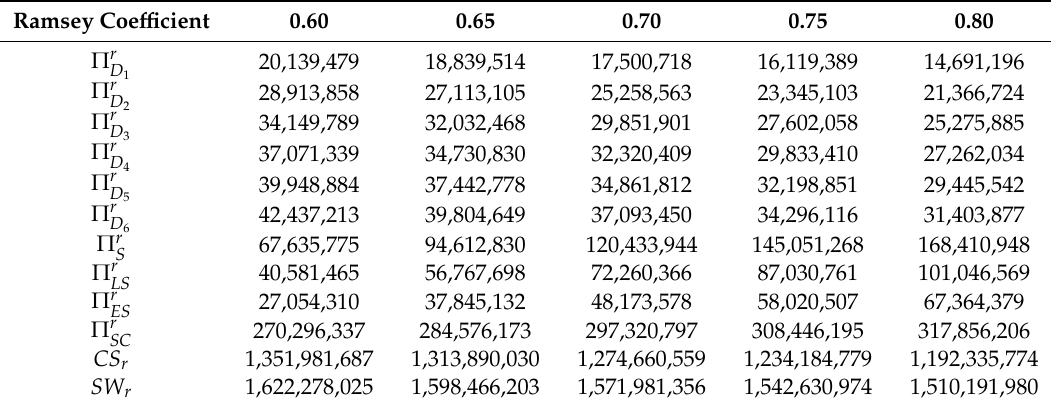
Table 8. Sensitivity analysis Results of Ramsey Coe ffi cient (Coordination with Ramsey pricing). Ramsey Coe ffi